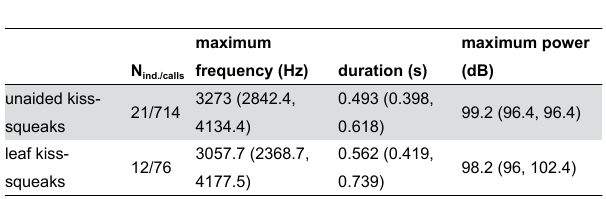
Median values are presented with 25 and 75 percentiles between